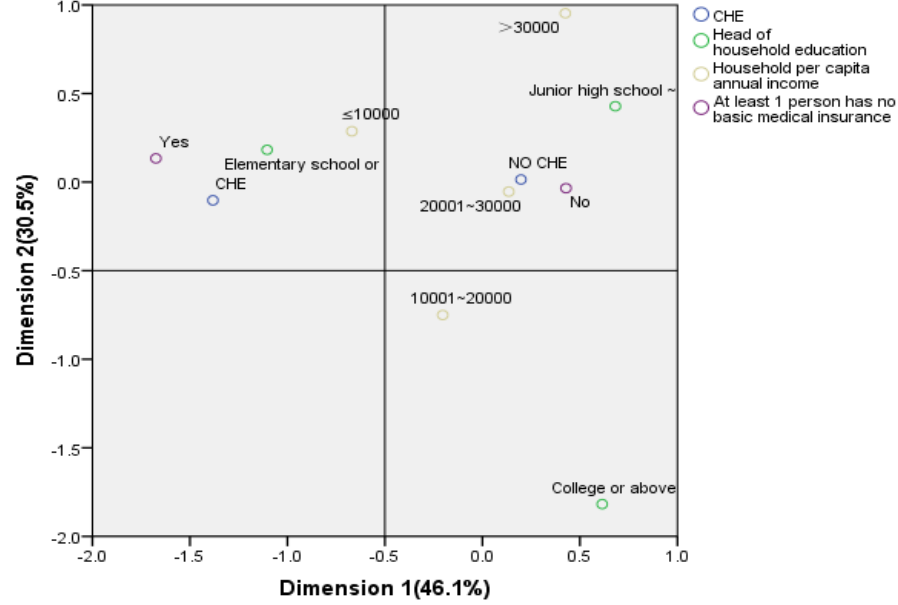
Figure 1. Correspondence plot of the data from migrant workers’ families.